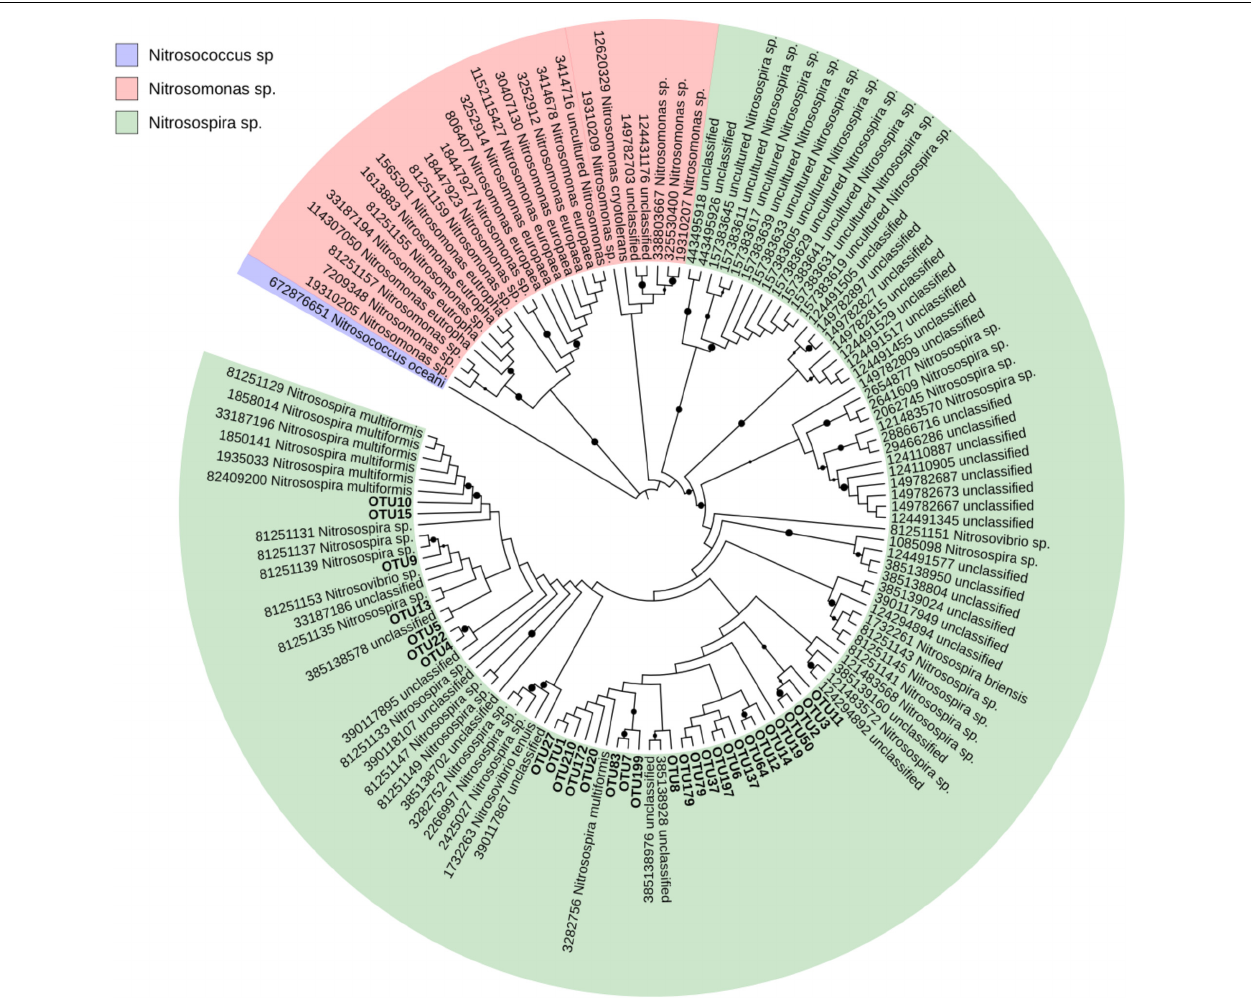
( Figure 3 ). Nitrosospira sp. PJA1 and Nitrosovibrio sp. RY3C were significantly positively correlated ( p ≤ 0.10) with N 2 O-N, NO 3 - N and the number of amo A gene copies ( Table 3 ). Surprisingly, Nitrosospira multiformis abundances showed significant negative correlations with N 2 O-N, NO 3 -N and the amo A gene copy number ( p ≤